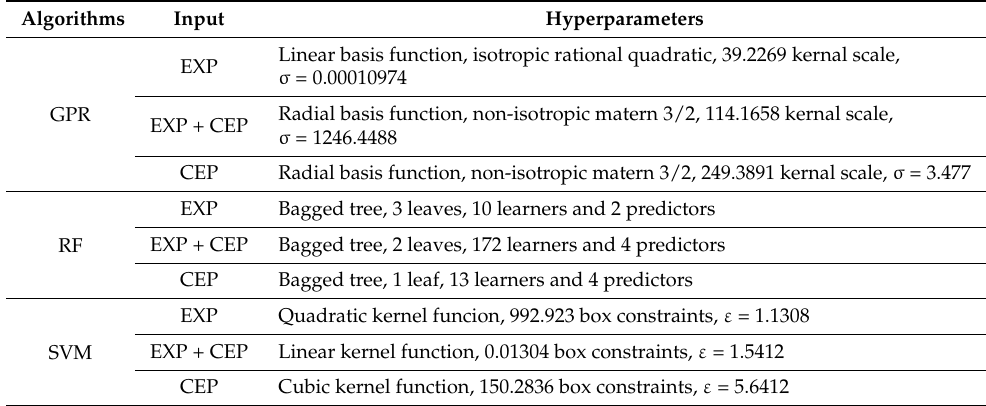
Figure 2. Graph of prediction vs. measured nuclear cross-section of 92 Mo ( n ,2 N ) 91 Mo for GPR machine learning algorithm. The black line is the ENDF/B-VIII.0 library data while the red dot is the predictions done by the GPR algorithms with ( a ) EXP, ( b ) CEP and ( c ) EXP + CEP as input. Table 2. Hyperparameters optimization using Bayesian Optimization .